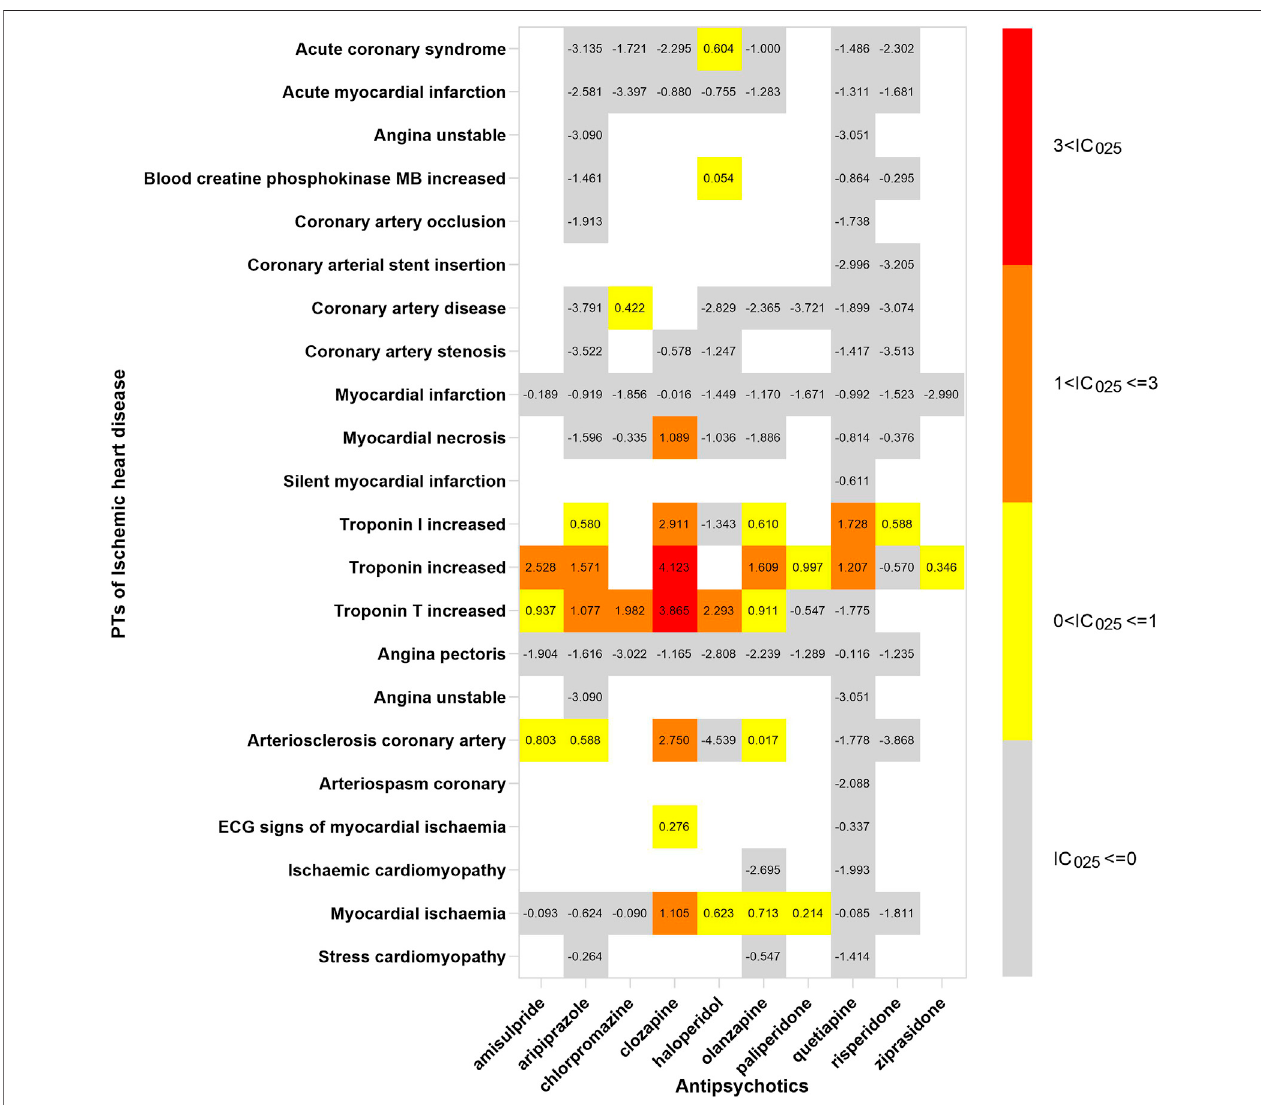
FIGURE 5 | The spectrum of ischemic heart disease induced by various APs. PT: preferred term; IC 025 : the lower end of the 95% con fi dence interval of the information component. The numbers in blocks represent the value of IC 025 of each combination of target antipsychotic and PT.